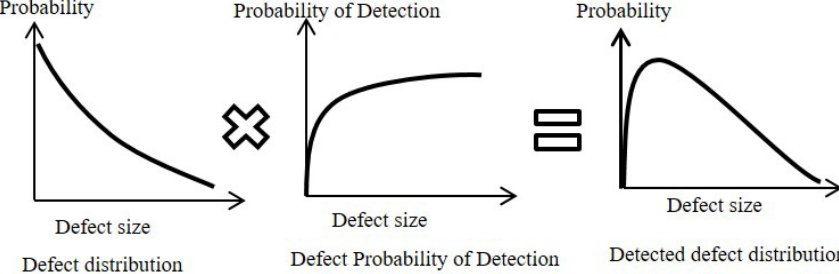
Figure 10. Relationship between crack size distribution, probability of detection, and detected crack size distribution (Amirafshari, 2019).